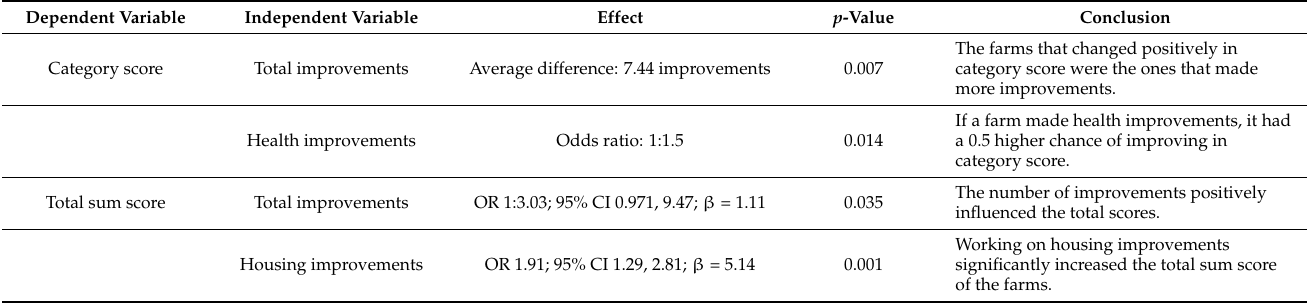
Table 9. Overview of the statistically significant results obtained in the statistical